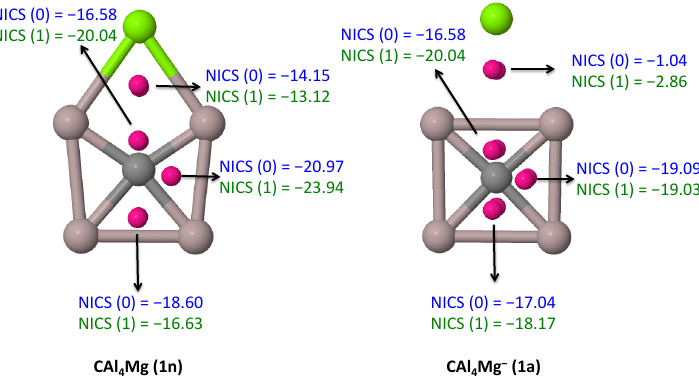
− 1n ) and CAl 4 Mg ( 4 Mg